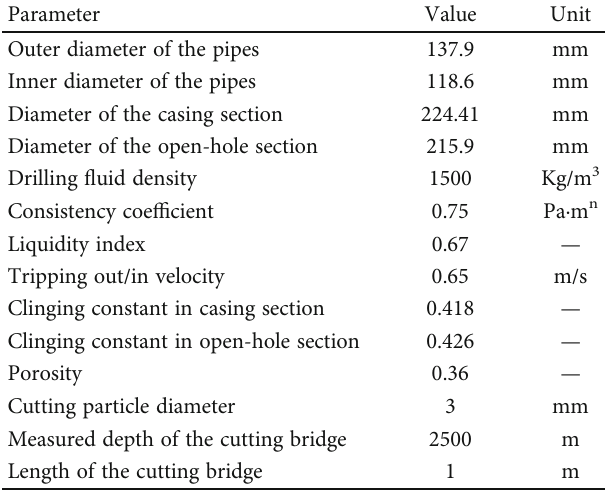
Table 2: Input data of the